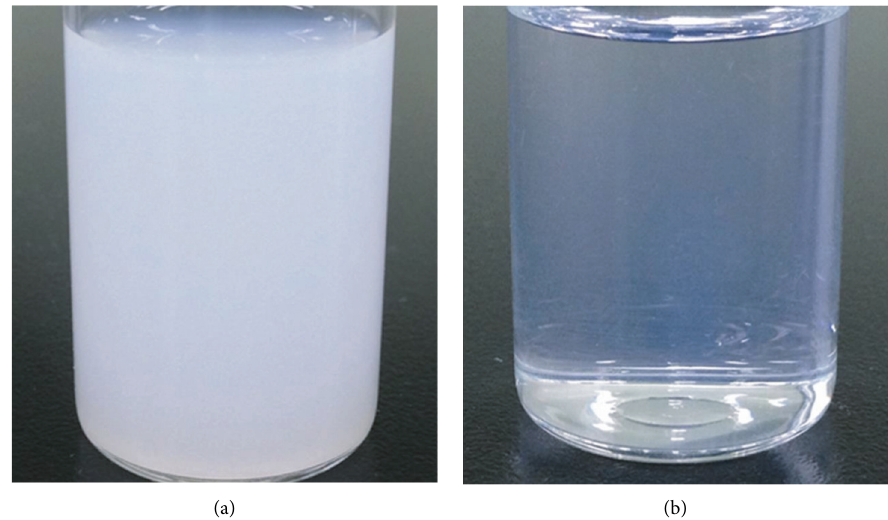
Figure 4: Comparison of transparency between emulsion and nanoemulsion CsA. (a) Emulsion CsA. (b) Nanoemulsion CsA. CsA,